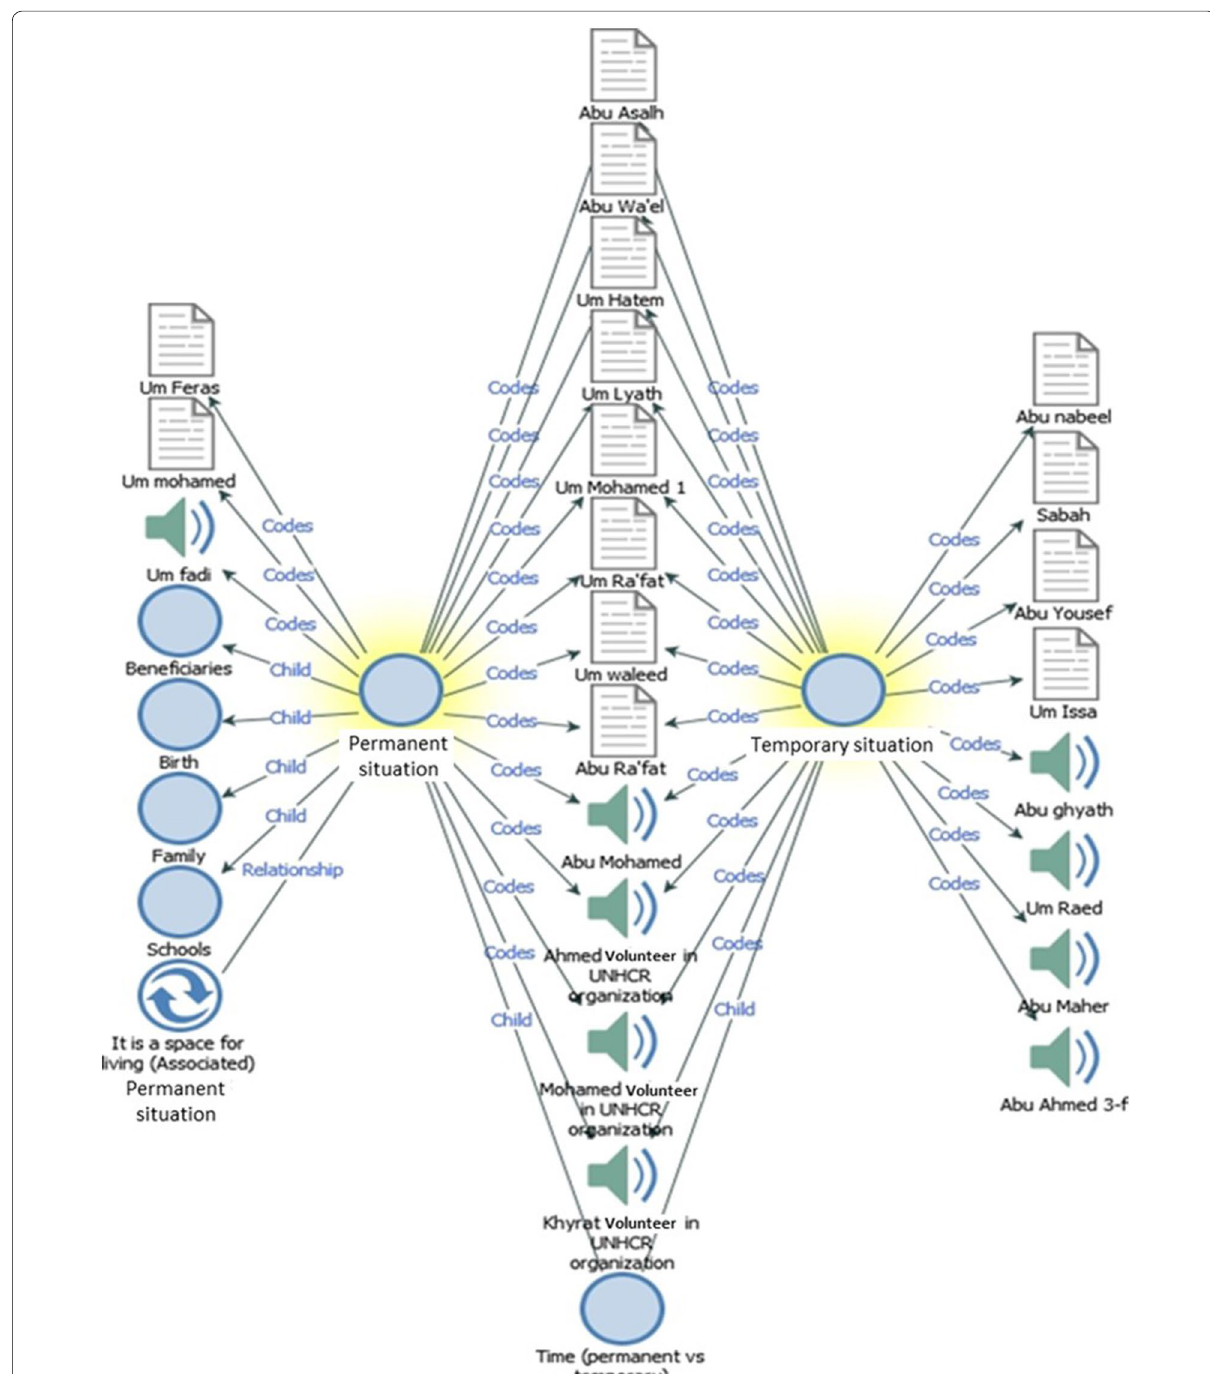
Fig. 4 Responses of refugees, experts, and NGOs regarding meaning of temporary and permanent